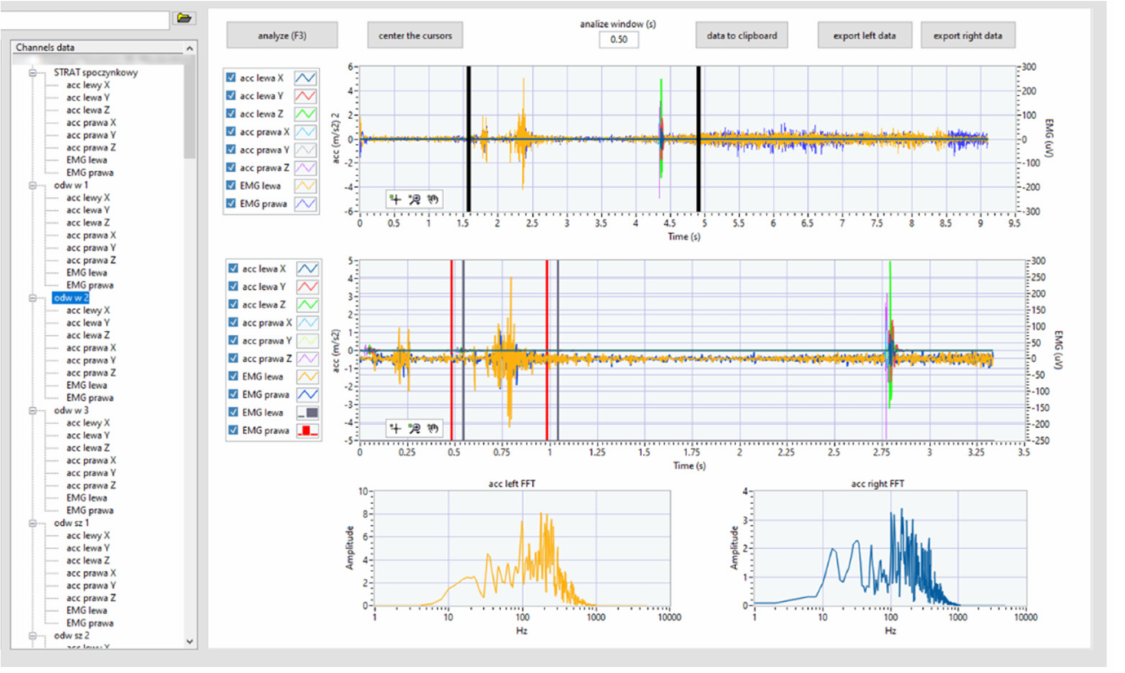
Figure 5. The analyzing system—front